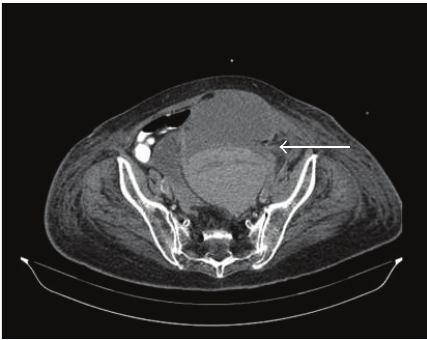
Figure 1: Rectus Sheath Hematoma : “hematocrit formation” point.